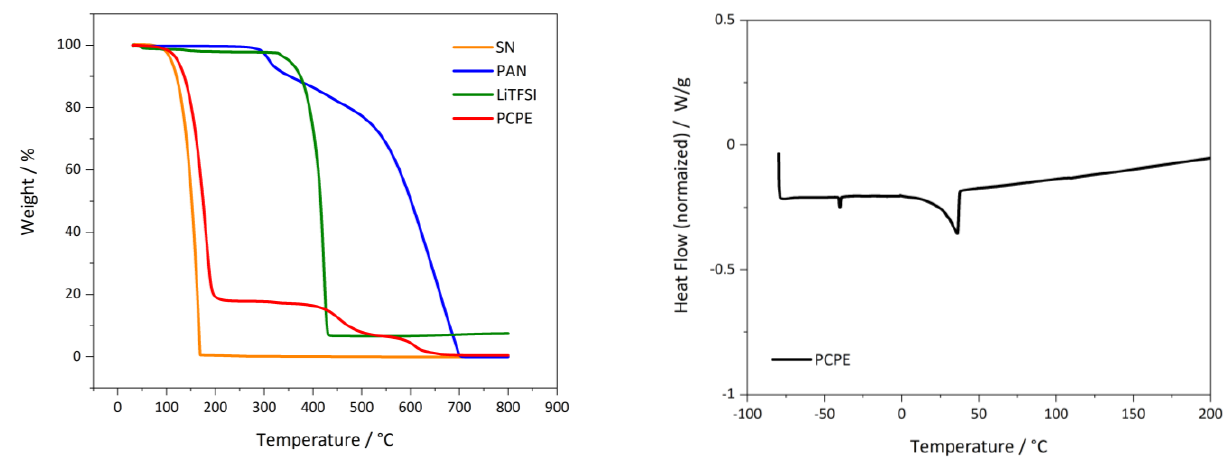
Figure 1. ( Left ): TGA measurement of PCPE (SN + 10 % PAN + 0.4 m/l LiTFSI; ( Right ): DSC graphs of bulk electrolyte components and PCPE (SN + 10% PAN + 0.4 m/l LiTFSI) electrolyte.